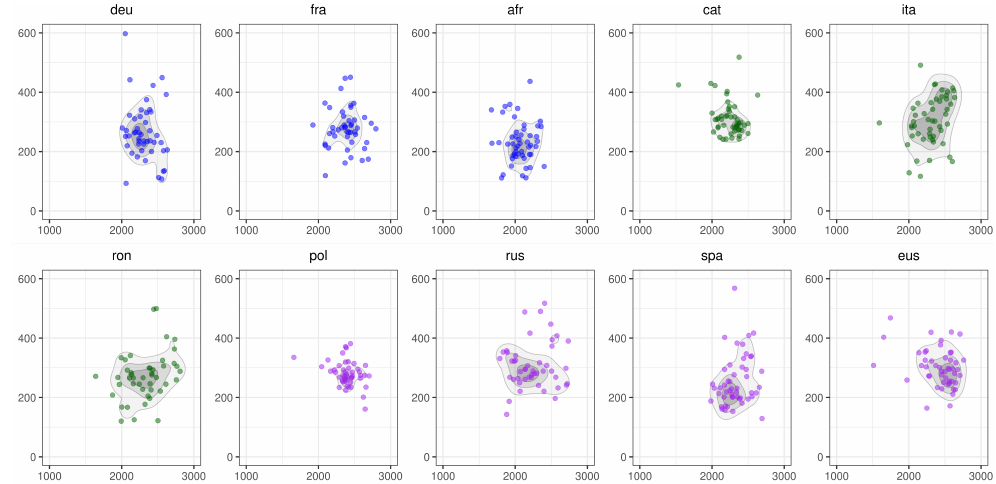
Figure 4. The distribution of formants for the vowel [i] across the 10 languages of the data set. The x-axis represents F2 and the y-axis indicates F1. The labels on the top of each sub-figure refer to the iso code of the 10 languages in the data set. The colors indicate the group to which the language is affiliated with in terms of number of timbres: blue = large, green = medium, purple = small.